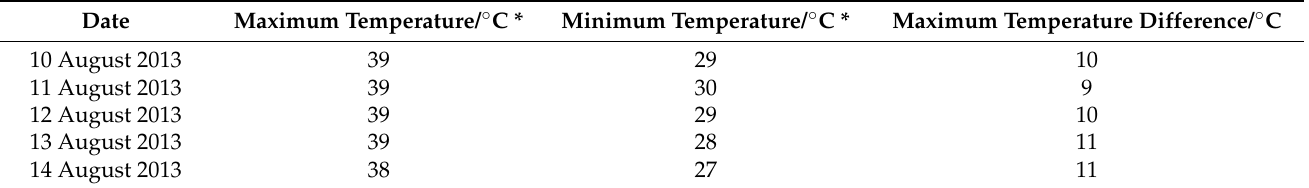
Table 2. Atmospheric temperature data.